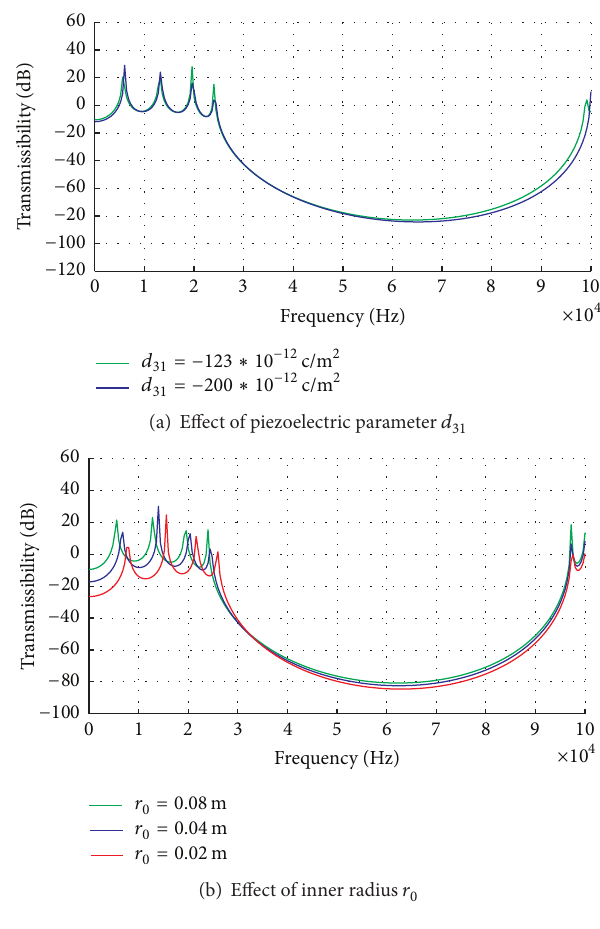
Figure 6: Effect of piezoelectric modulus 𝑑 31 and inner radius 𝑟 0